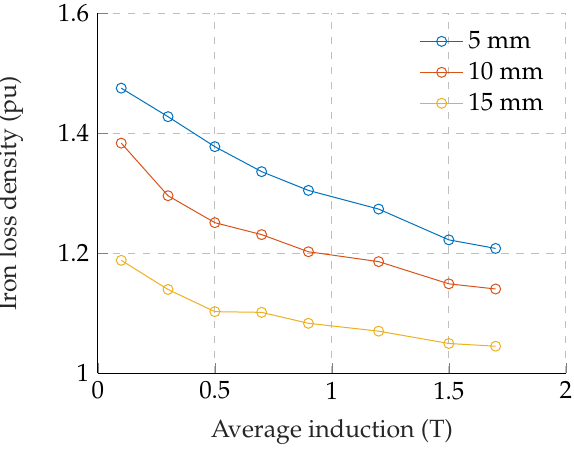
Figure 3. Iron loss curves of different sample widths at 60 Hz.